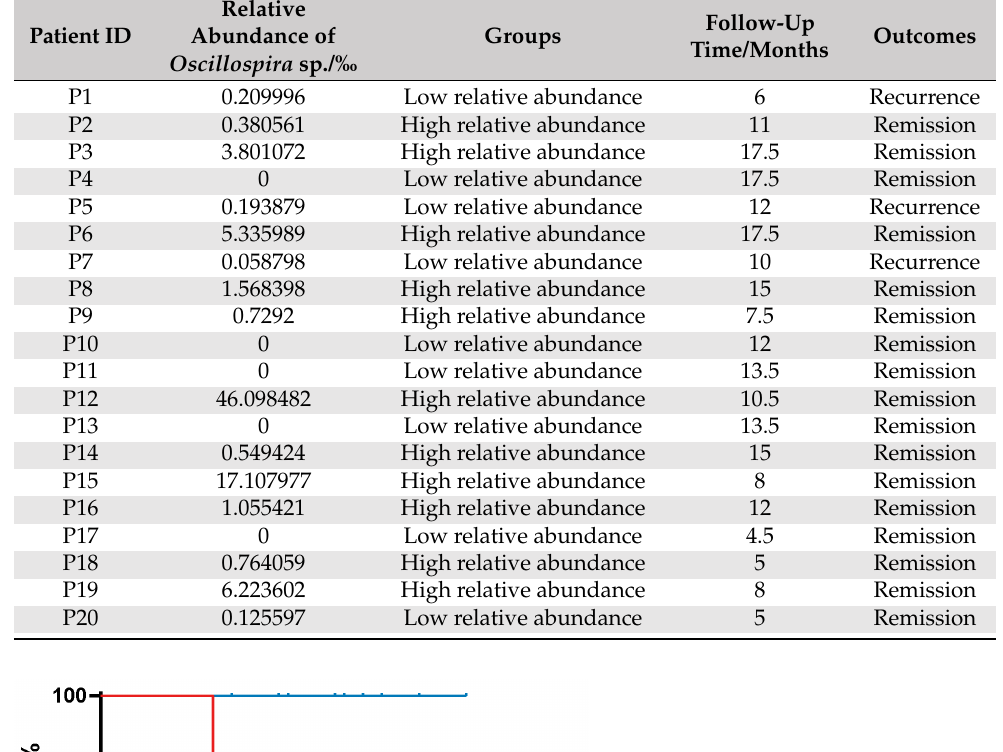
longer period of time when compared to the low abundance group ( p = 0.0426). Table 2. Relative abundance of Oscillospira sp. in residual intestine segment and follow-up.